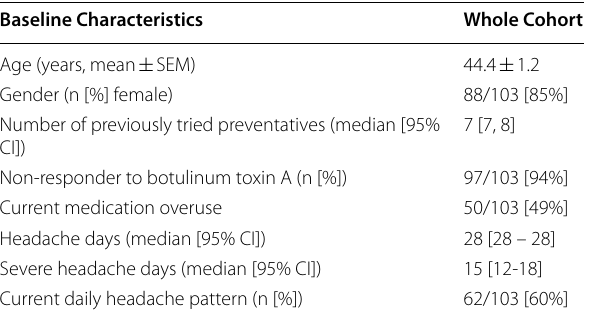
SEM Standard error of the mean. CI Confidence interval